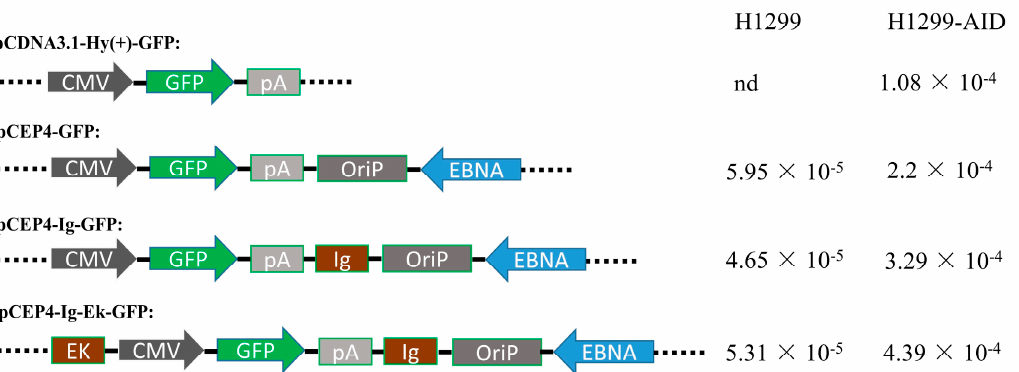
Figure 2. Structure of the plasmids with or without enhancers and mutation rate (mutation rate/15 days) in H1299 and H1299-AID cells. CMV: Human cytomegalovirus immediate-early promoter/enhancer. GFP: green fluorescent protein. pA: SV40 polyadenylation signal. OriP: EBV origin of replication. EBNA: Epstein-Barr nuclear antigen. EK: Ek enhancer sequence. lg: Ig enhancer sequence.